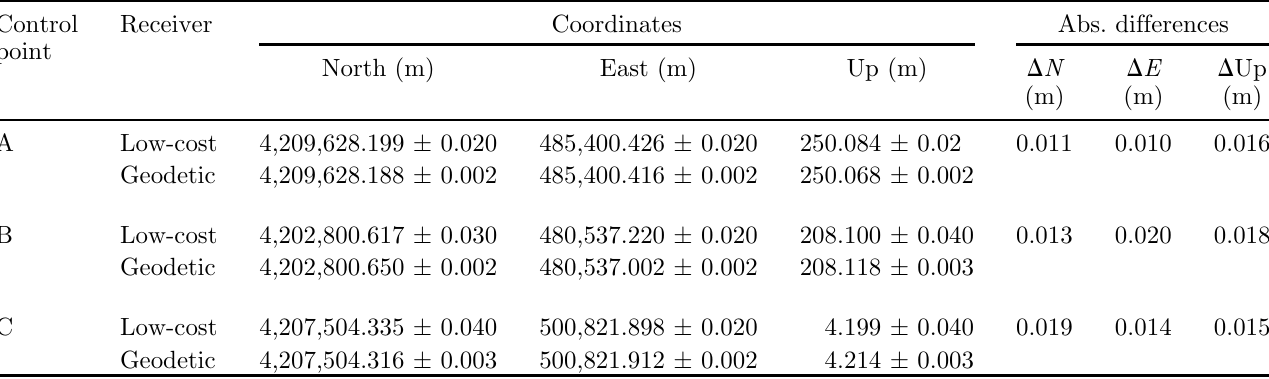
Table 13. Positioning results for long baselines.